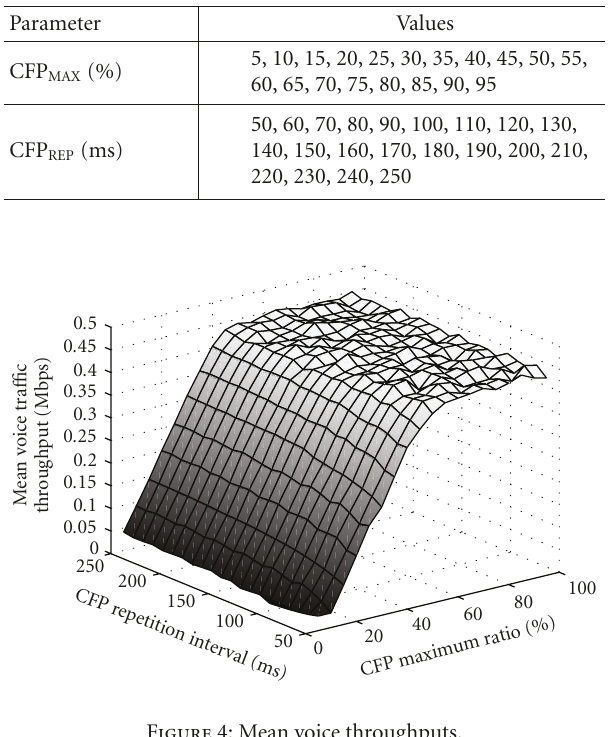
Figure 4: Mean voice